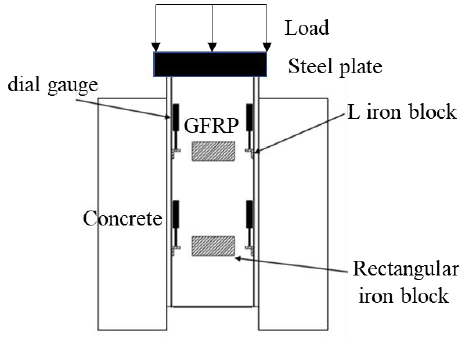
Figure 4. Setup of the push-out tests.